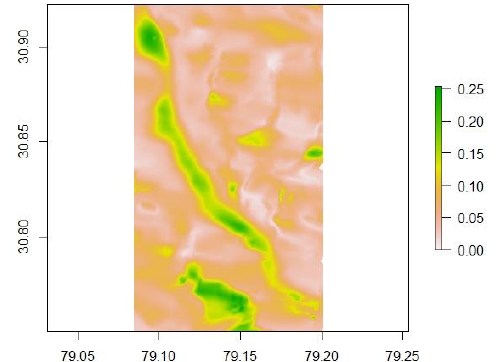
Figure 8: Gangotri glacier velocity map using descending pass TerraSAR-X images (25 June 2012 and 6 July 2012) (Figure scale in m day -1 ).